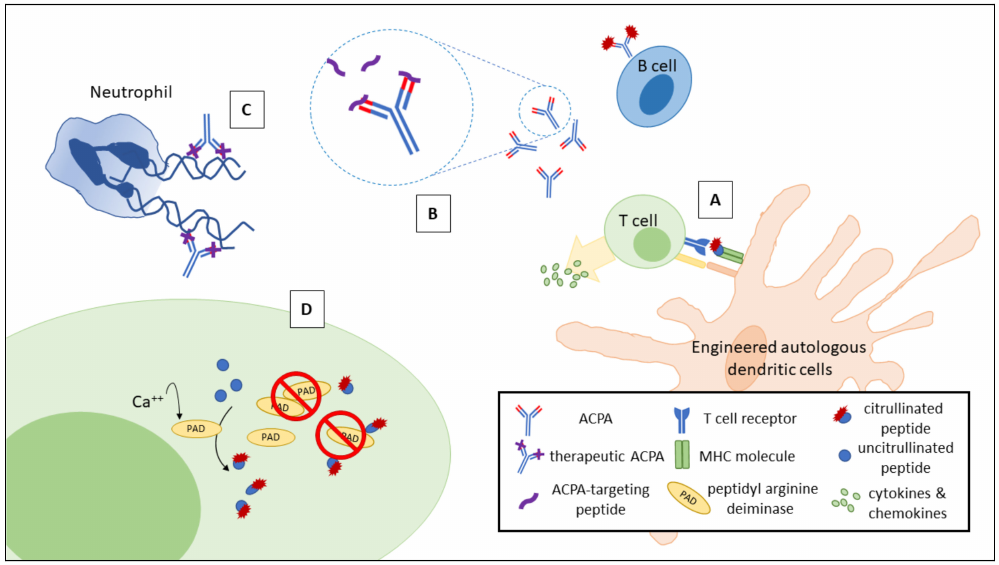
Figure 2. Potential treatment strategies for ACPA-mediated RA. Citrullinated peptide